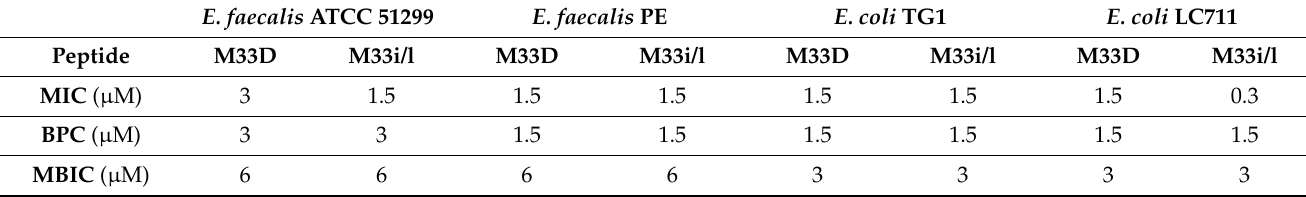
Table 2. Biofilm inhibition. M33D and M33i/l biofilm inhibition against E. faecalis ATCC 51299 , E. faecalis PE, E. coli TG1, and E. coli LC711. Values for minimal inhibitory concentration (MIC), biofilm prevention concentration (BPC), and minimal biofilm inhibitory concentration (MBIC) are